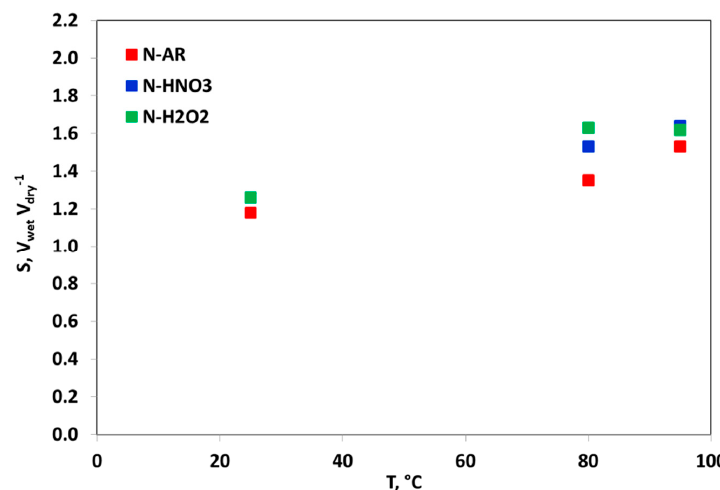
Figure 5. Influence of the liquid water temperature on the swelling of N-AR (red squares), N-HNO3 (blue squares) and N-H2O2 (green squares) membranes.